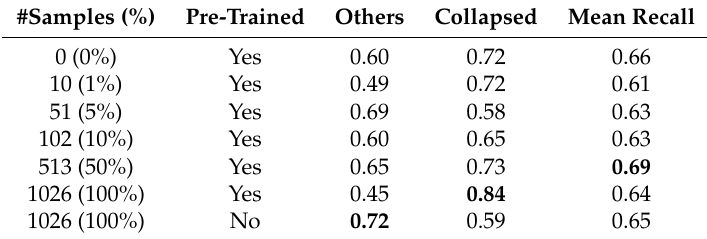
Table 8. Results of the generalization experiments. The best performances among each category are